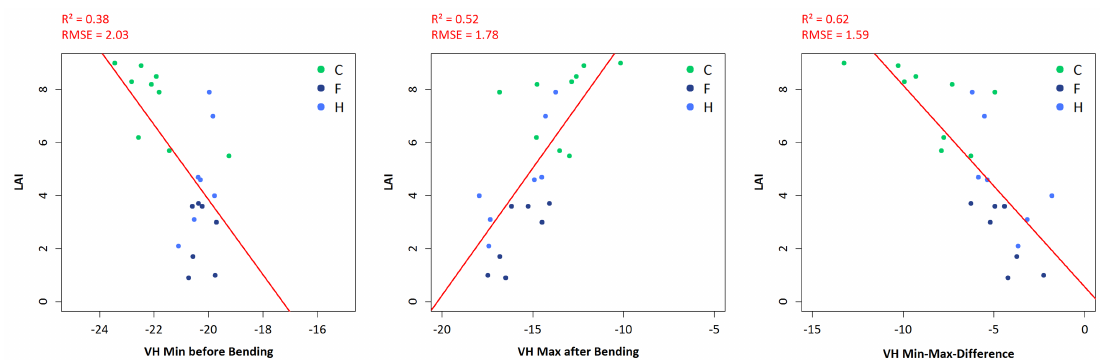
Figure 14. Scatter plots of LAI of three barley fields related to minimum VH backscatter before bending of the ears ( left ), maximum VH backscatter after bending of the ears ( center ) and the difference between both ( right